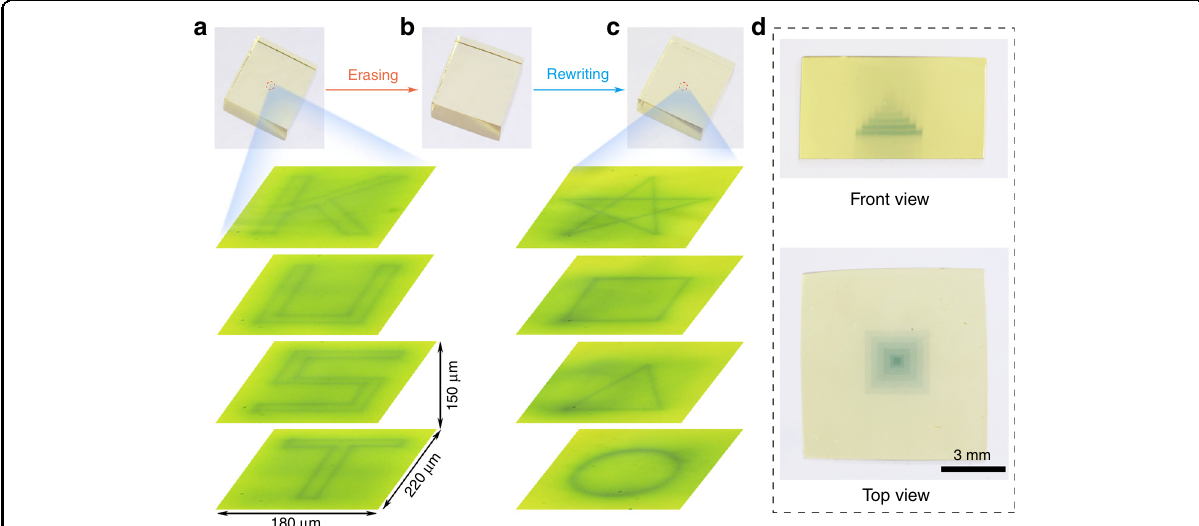
Fig. 5 Demonstration of 3D optical data storage and information encryption. a The 3D optical information written in various layers of the glass, the photograph of the transparent glass with the “ KUST ” information under the daylight (upper photo), and the optical microscope images of “ KUST ” information observed by using an optical microscope. b The photograph of glass after the “ KUST ” information erasing. c The 3D optical information rewritten in various layers of the glass, the photograph of the transparent glass with the “ pentacle, quadrate, triangle and circle pattern ” information under daylight (upper photo) and the optical microscope images of “ pentacle, quadrate, triangle and circle ” information observed by using optical microscope. d The 3D structure inside the glass from the front view and top view under